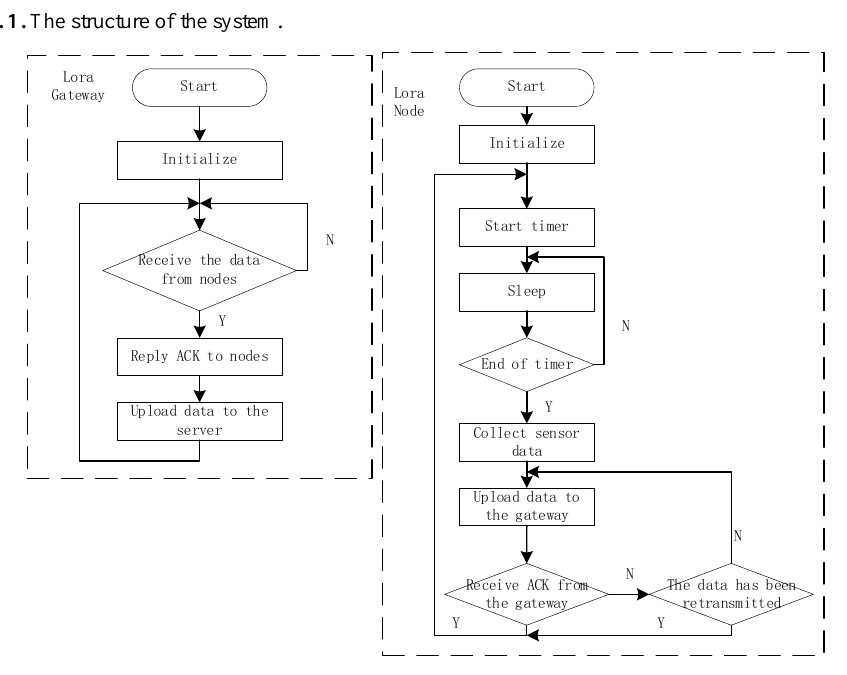
Fig. 2. The workflow of the system